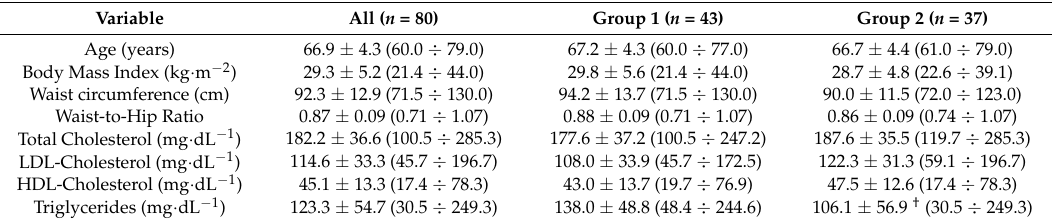
Table 1. Baseline characteristics of the study groups.